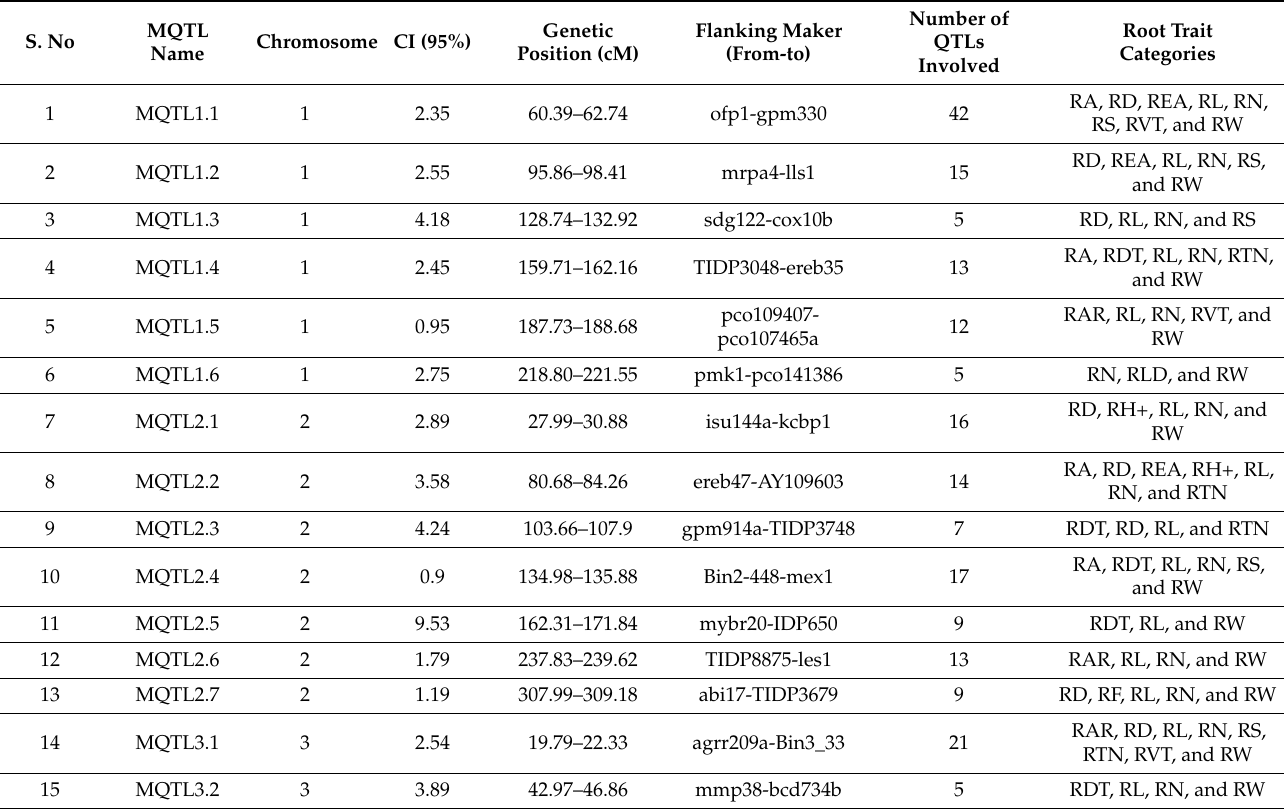
Figure 4. The distribution of different MQTLs on maize chromosomes. The explanation for different colours utilized to represent the MQTL is given at the bottom of the figure. Table 1. A summary of MQTLs identified during the present study.